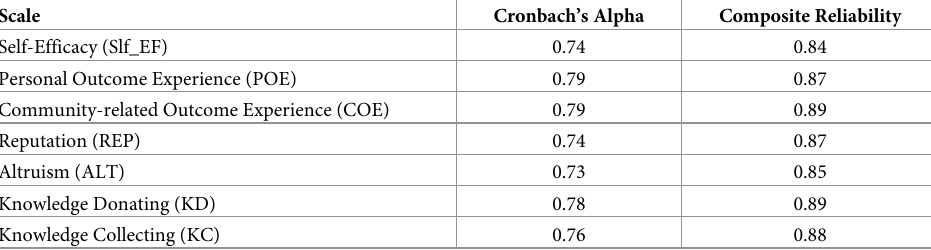
Table 5. Cronbach’s Alpha and composite reliability